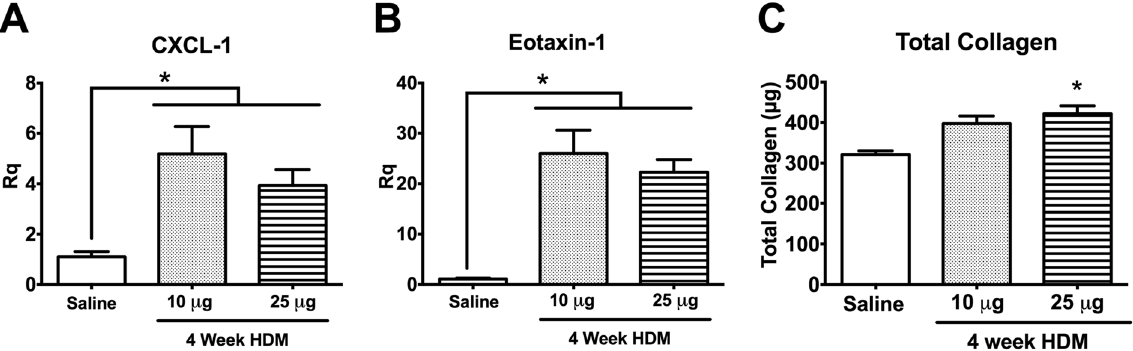
Figure 8. 4-week low and high dose HDM exhibit similar upregulation in CXCL-1 and eotaxin-1 expression but increased collagen deposition was only observed with higher HDM dose. Both 4-week HDM doses exhibited similar increase in CXCL-1 and eotaxin-1 expression ( A,B ). However, only the higher dose HDM significantly increased total collagen content relative to Saline ( C , n = 6–8/group, * p <